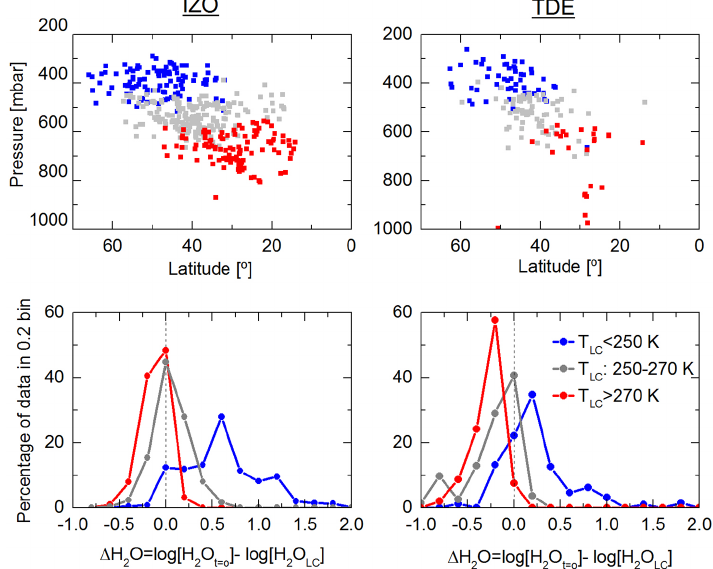
Figure 7. Trajectory-based analysis of the last condensation (LC) point for non-SAL conditions. Upper panels: location (pressure-latitude) of LC point. Bottom panels: histograms for (cid:49) H 2 O = log [ H 2 O t = 0 ]− log [ H 2 O LC ] . The different colours correspond to different T LC groups: T LC < 250K (blue line), 250K <T LC < 270K (grey line) and T LC > 270K (red